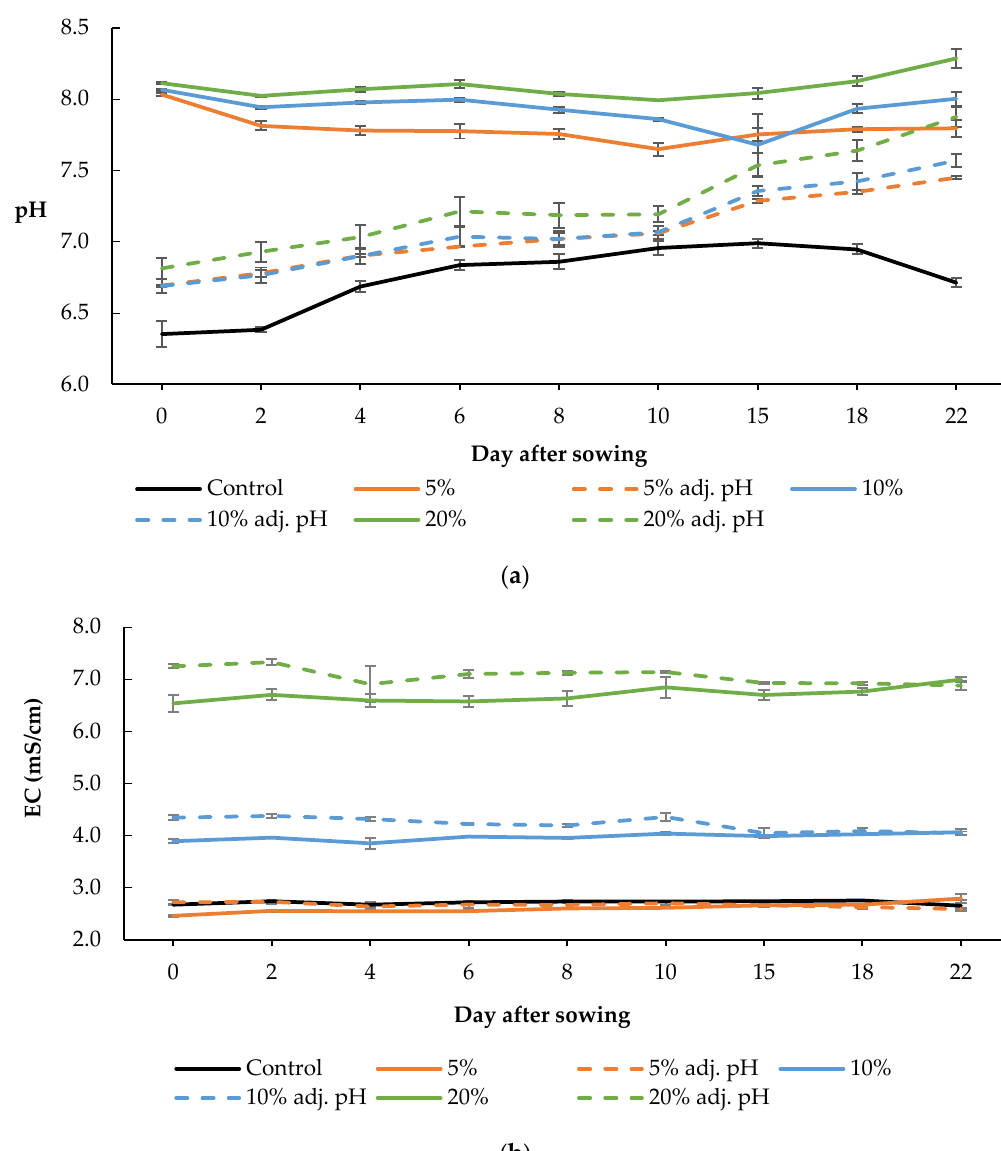
Figure 2. pH ( a ) and electrical conductivity (EC) ( b ) of different digestate solutions during the cultivation period. Data presented are mean values ± standard error ( p < 0.05).